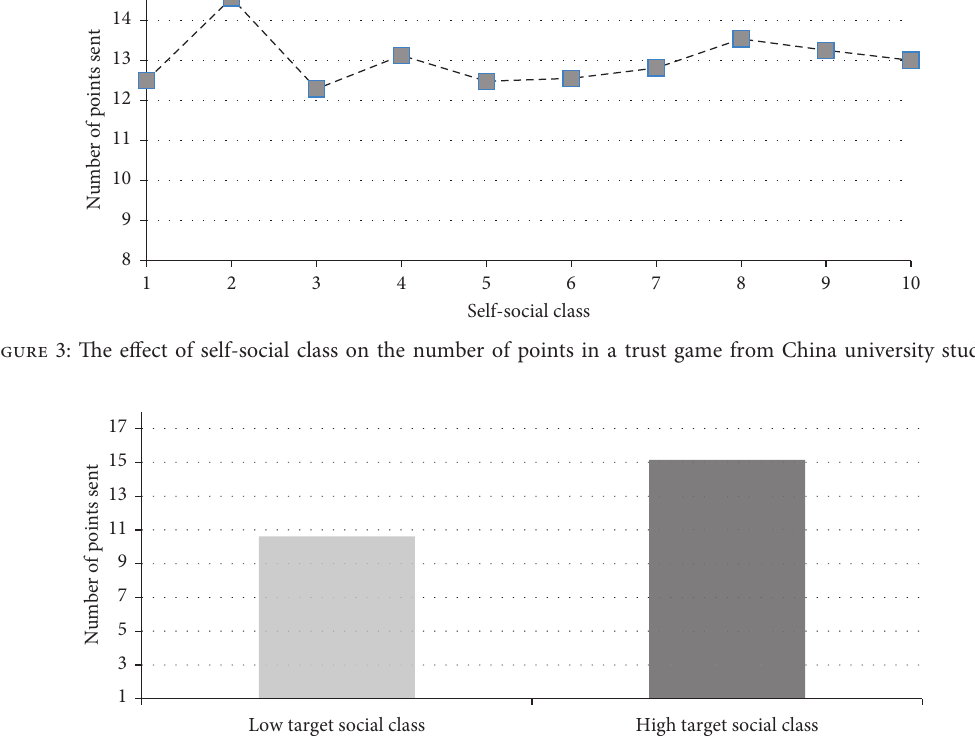
Figure 4: The effect of target social class on the number of points in a trust game from China university students. Table 4: Means and standard deviations of the number of points in a trust game per condition in the study. Number of points sent